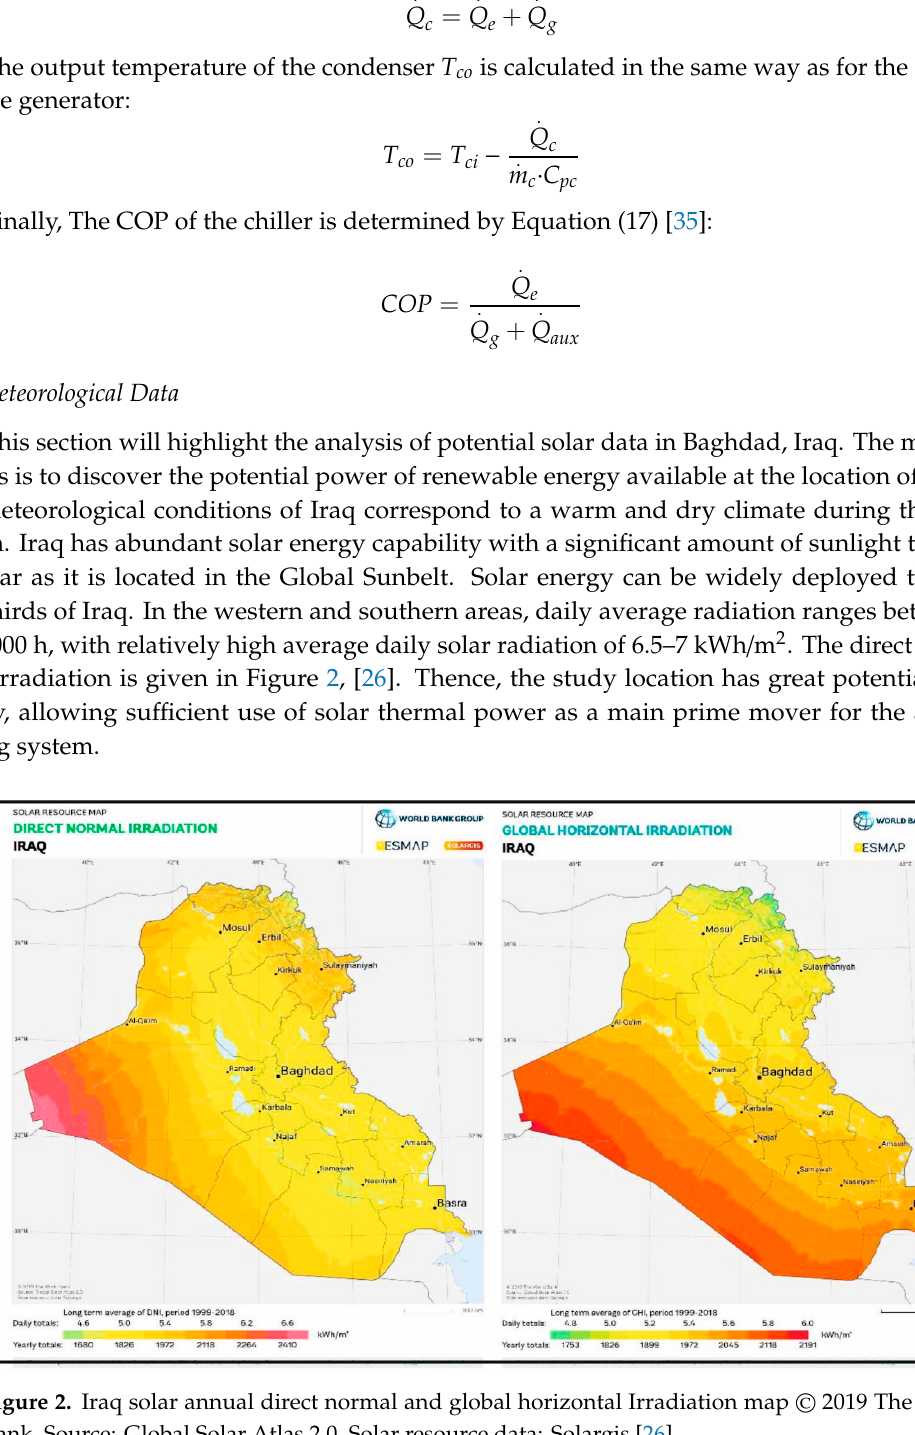
Table 3. Specifications of the YAZAKI WFC-SC10 absorption chiller [34].